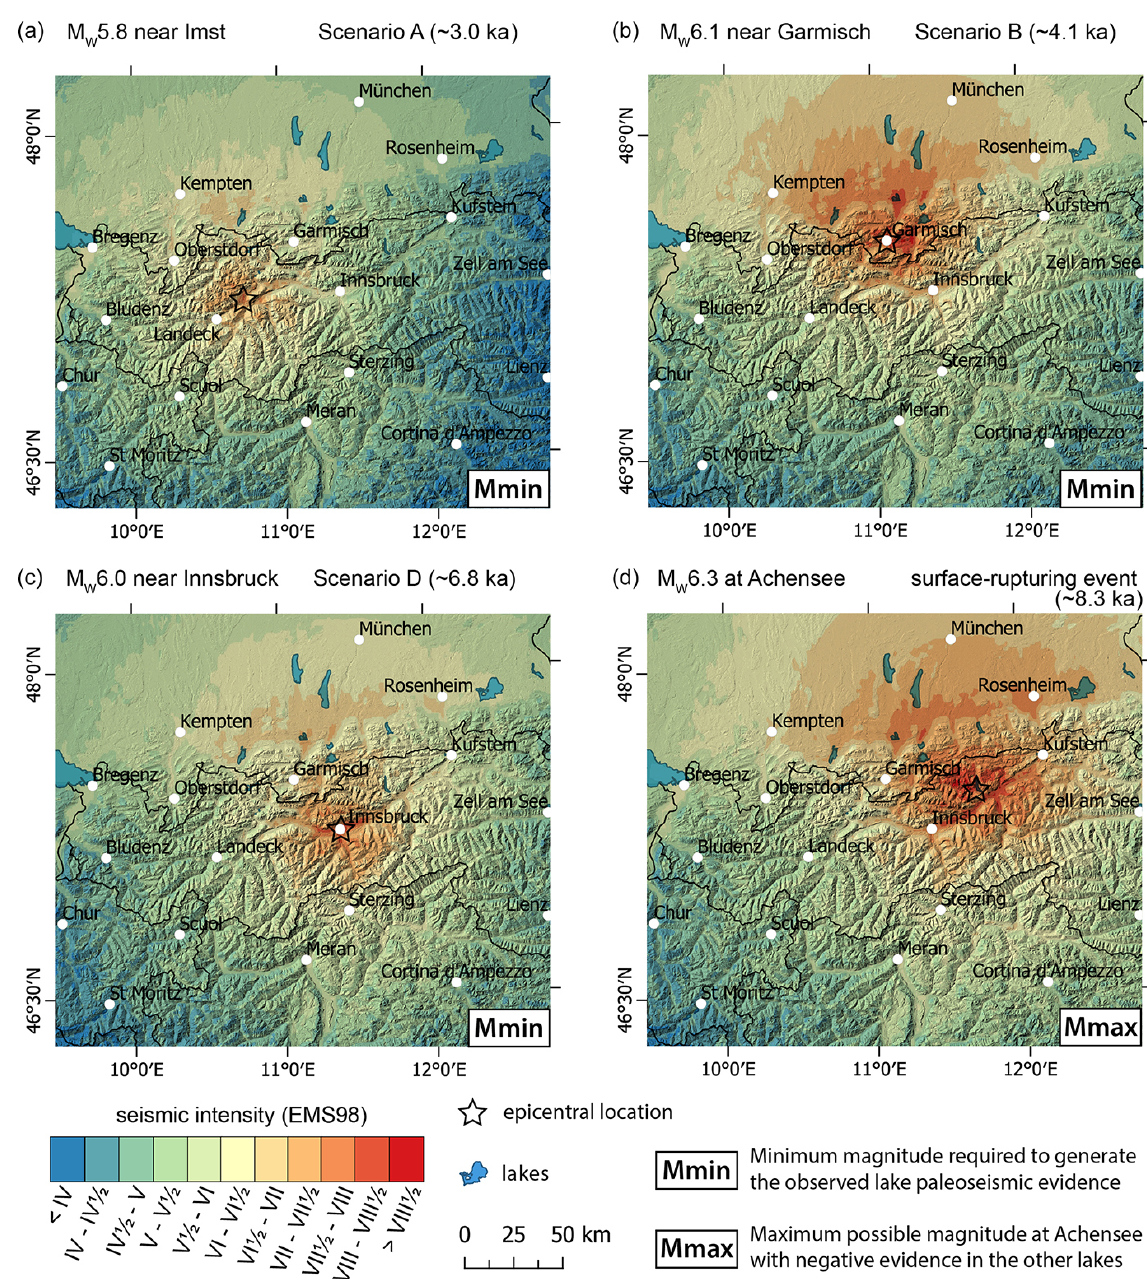
Figure 7. ShakeMaps of selected paleo-earthquake scenarios. Magnitudes and epicentral location are based on the calculated source areas and minimum magnitudes and evaluation based on the relative size of the earthquake-related sedimentary imprint and the location of earthquake- triggered rockslides (see Sect. 4.2). The ShakeMaps show seismic intensities (EMS-98) calculated for the minimum magnitude estimates of the paleo-earthquakes with presumed epicenters (a) near Imst at ∼ 3 . 0ka, (b) close to Garmisch-Partenkirchen at ∼ 4 . 1ka, and (c) near Innsbruck at ∼ 6 . 8ka. In contrast, (d) presents the maximum possible magnitude of M w 6.3 for a surface-rupturing earthquake at Achensee without exceeding the seismic intensity threshold at Plansee and Piburgersee. The ShakeMaps are based on empirical relations of intensity to distance (Sponheuer, 1960) and magnitude to epicentral intensity (Rudloff and Leydecker, 2002), modified by macroseismic data of recorded earthquakes and epicentral intensities of historical events and corrected for site effects. The calculated seismic intensities at major towns for the different paleo-earthquake scenarios are provided in Table